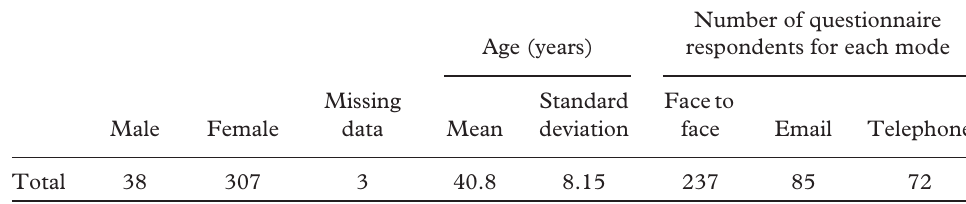
Table 1. Participant sample descriptive